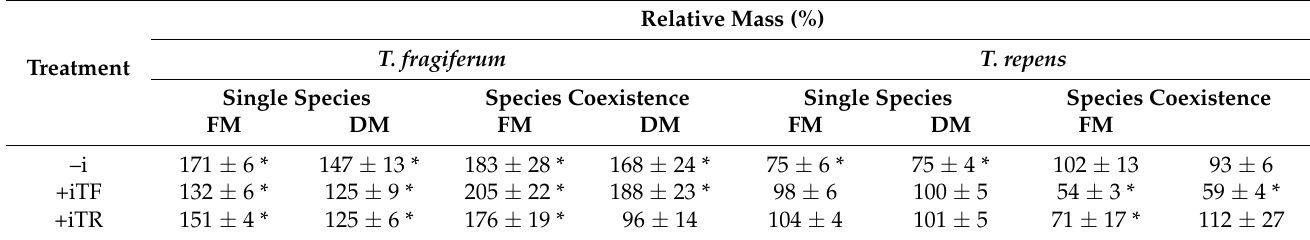
Table 6. Relative effect of NaCl (values from the respective treatment combinations without NaCl were indicated as 100%) on total fresh and dry mass of shoots of the two Trifolium species.